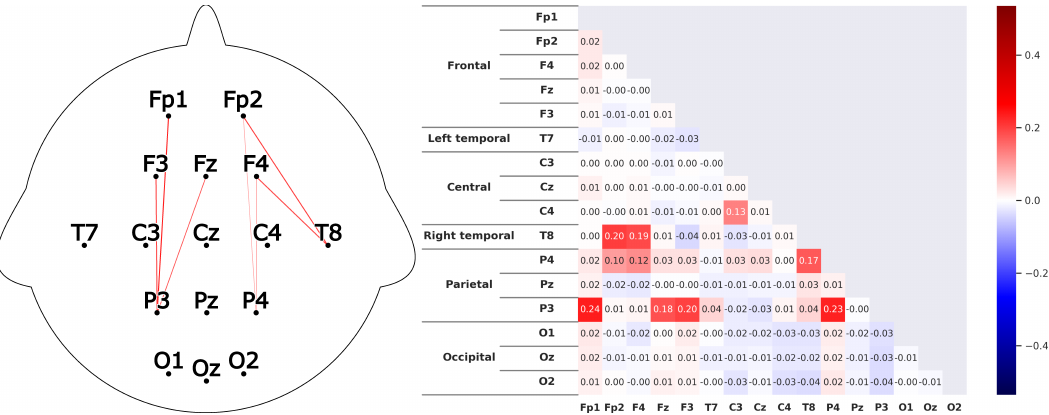
Figure 14. Difference of the results between the HKT process owner and the BSC process owner as described in Figure 10. Colorscale maximum and minimum are set to the +maximum and -maximum absolute value of the examined differences.